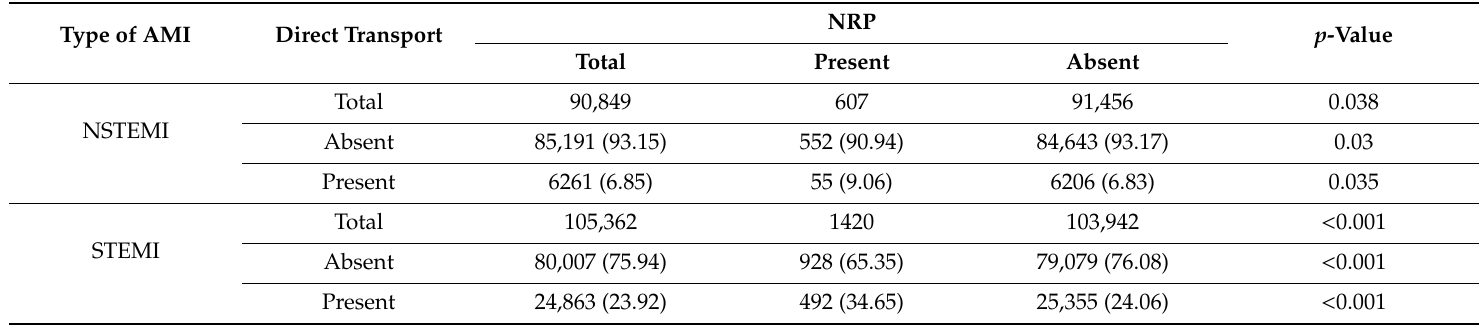
Table 2. The relationship between the type of myocardial infarction (MI) and direct transport in light of no-reflow phenomenon (NRP) occurrence. Type of AMI